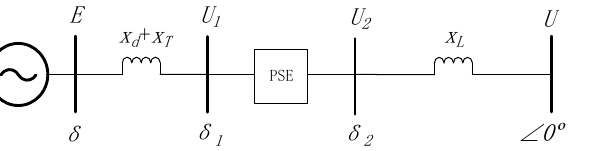
Figure 12. Equivalence diagram with MMC-based phase sequence exchanging system.